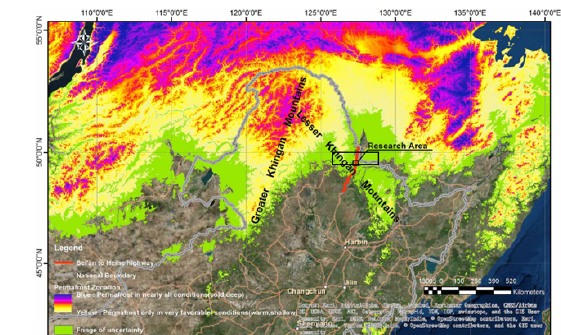
Figure 1. The overview of permafrost region in this study and high-latitude permafrost distribution in Northeast China with data from Zurich University, Switzerland